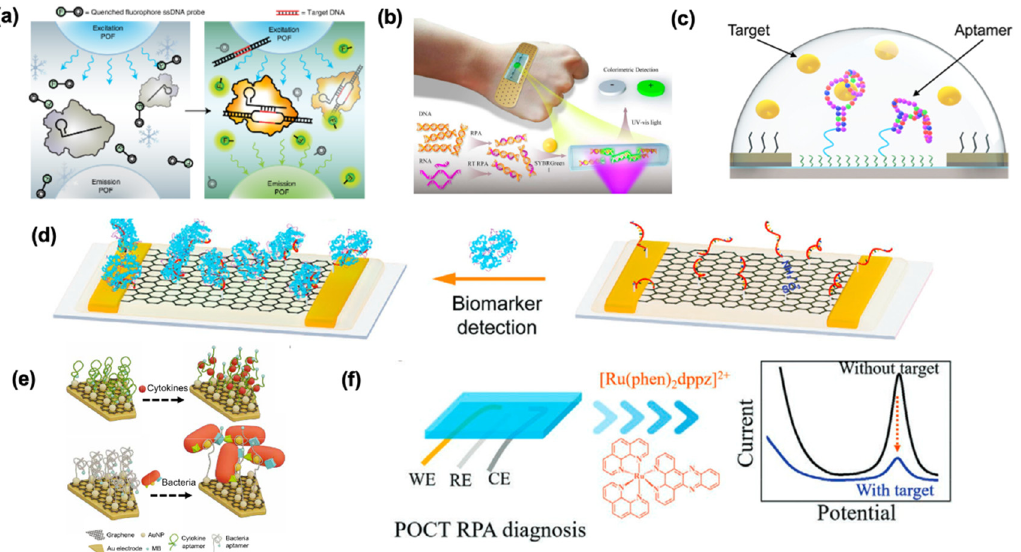
Figure 5. Sensing mechanisms of optical, electrochemical, and FET-based wearable biosensor. ( a